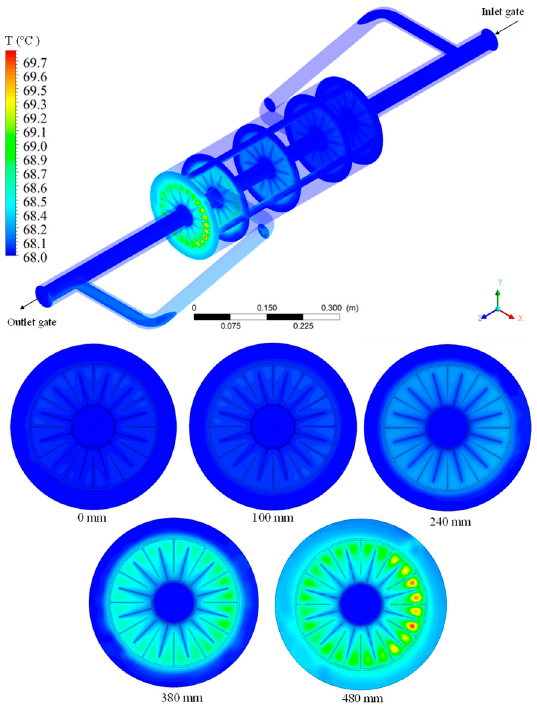
Figure 13. Temperature distribution in TTHX domains for 0% of the PCM in a liquid state (t = 14,343 s).